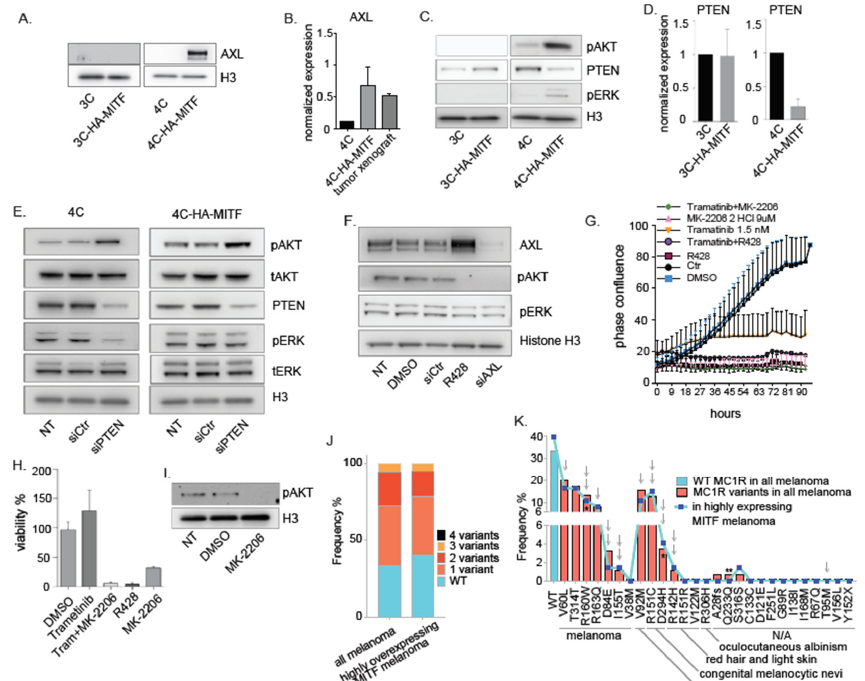
Figure 4. AXL and PI3 / AKT pathway mediates HA-MITF transformation through PTEN downregulation. ( A ) Western Blot analysis of AXL in 3C-HA-MITF and 4C-HA-MITF compared to parental cell lines. Histone H3 was used as loading control. Representative blot from three di ff erent experiments. ( B ) Graphs represent RT-PCR expression data comparing AXL levels in 4C-HA-MITF, and in 4C-HA-MITF cells xenografted in mice normalized to 4C cells and plotted as mean ± SD ( n = 3). ( C ) Western Blot analysis of pAKT, PTEN and pERK after cholera toxin starvation in 3C-HA-MITF and 4C-HA-MITF normalized to 3C and 4C levels. Histone H3 was used as loading control. Representative blot from three different experiments. ( D ) Graphs represent RT-PCR expression data comparing PTEN levels in 3C-HA-MITF, and in 4C-HA-MITF cells normalized to control 3C and 4C cells and plotted as mean ± SD ( n = 3). (E) Western Blot analysis of the indicated proteins levels after PTEN depletion in the parental 4C cell line and transduced 4C-HA-MITF compared to scrambled siRNA and non-treated control (NT). Histone H3 was used as loading control. Representative blot from three different experiments. ( F ) Western blot analysis of AXL, pAKT and pERK in 4C-HA-MITF treated with AXL inhibitor R428 (2 μ M) and siAXL compared to non-transduced (NT), scrambled siRNA and DMSO control. Histone H3 was used as loading control. Representative blot from three different experiments. ( G ) Growth curves measured using IncuCyte of 4C-HA-MITF cells untreated (NT), or control treated with DMSO (DMSO), or MK-2206 (9 μ M), Trametinib (1.5 nM), R428 (2 μ M), a combination of Trametinib (1.5 nM) with MK2206 (9 μ M), and a combination of Trametinib (1.5 nM) and R428 (2 μ M) ( n = 3). ( H ) Graph represents cell viability measurements using MTS of 4C-HA-MITF after 90 hours treatment with the indicated inhibitor treatments normalized to DMSO treated cells and plotted as mean ± SD ( n = 3). ( I ) Western blot analysis of testing the efficacy of the MK-2206 inhibitor in 4C control. ( J ) Frequency of MC1R co-occurring mutations in the TCGA melanoma cohort ( n = 471), and in 73 melanoma cases from the same cohort that displayed high expression of MITF (cut off = Z-score ≥ 1). ( K ) Frequency of the indicated MC1R mutations in the TCGA melanoma cohort ( n = 471) and in the 73 cases with high expression of MITF. Their associated phenotypes according to [48–50] are indicated (N/A is not applicable or not known) as well as whether the variant is highly (double arrow), or mildly (single arrow) impairing MC1R function. * indicates the MC1R variants co-occurring in Hermes 4C cell lines; ** indicates the synonymous mutation of the MC1R that does not alter the amino acid sequence of